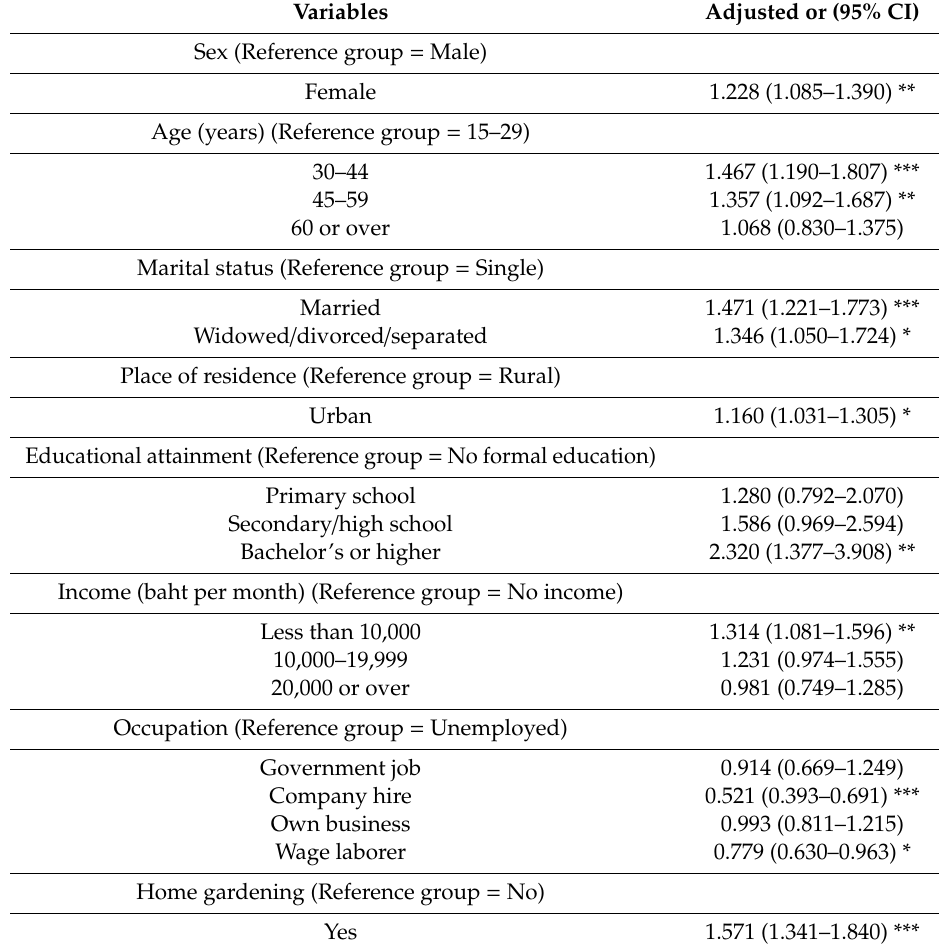
Table 2. Binary logistic regression of socio-demographic characteristics and home gardening in association with su ffi cient FV intake ( N =